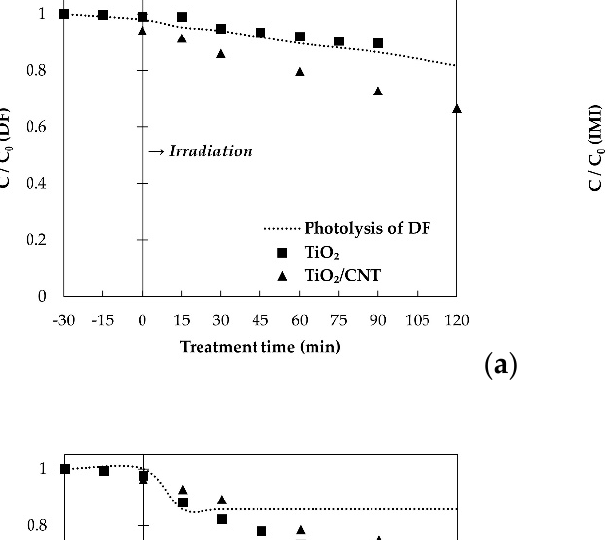
Table 1. Intrinsic degradation rate constants for DF, MI, BT and MB along with the intensification factors due to TiO 2 modification with CNT.